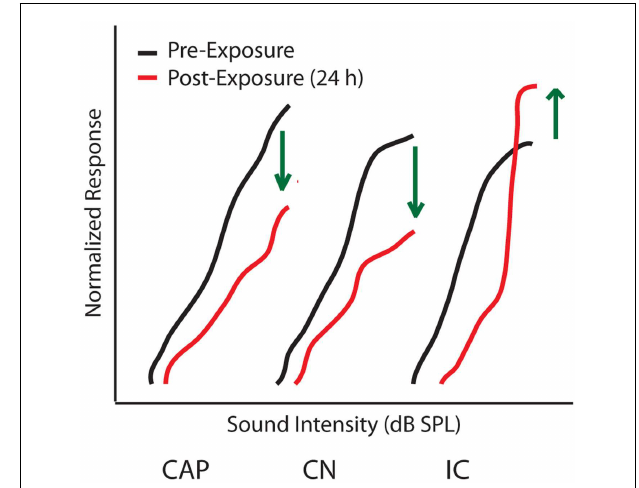
FIGURE 3 | Origins of central gain enhancement . Schematized data for amplitude-level functions to a 1kHz tone chronically recorded from chinchillas at the round window (CAP), cochlear nucleus (CN), and inferior colliculus (IC), before (black lines) and 24h after (red lines) noise-exposure of 105dB SPL at 2.8kHz for 2h. Green arrows indicate the direction of amplitude change after noise-exposure. Responses are normalized to maximum response before the noise-exposure [modified from Ref.